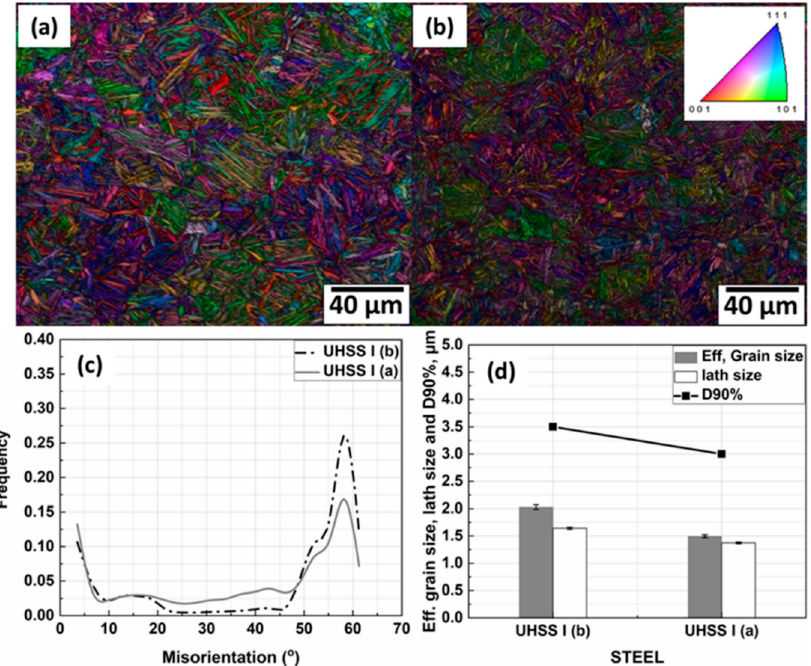
Figure 6. IPF with superimposed IQ map of forged and air-cooled bar of UHSS I without ESR ( a ) and with ESR ( b ) (scale bar is 40 µ m), grain boundary misorientations ( c ), mean lath size, mean e ff ective grain size and D90% ( d ).